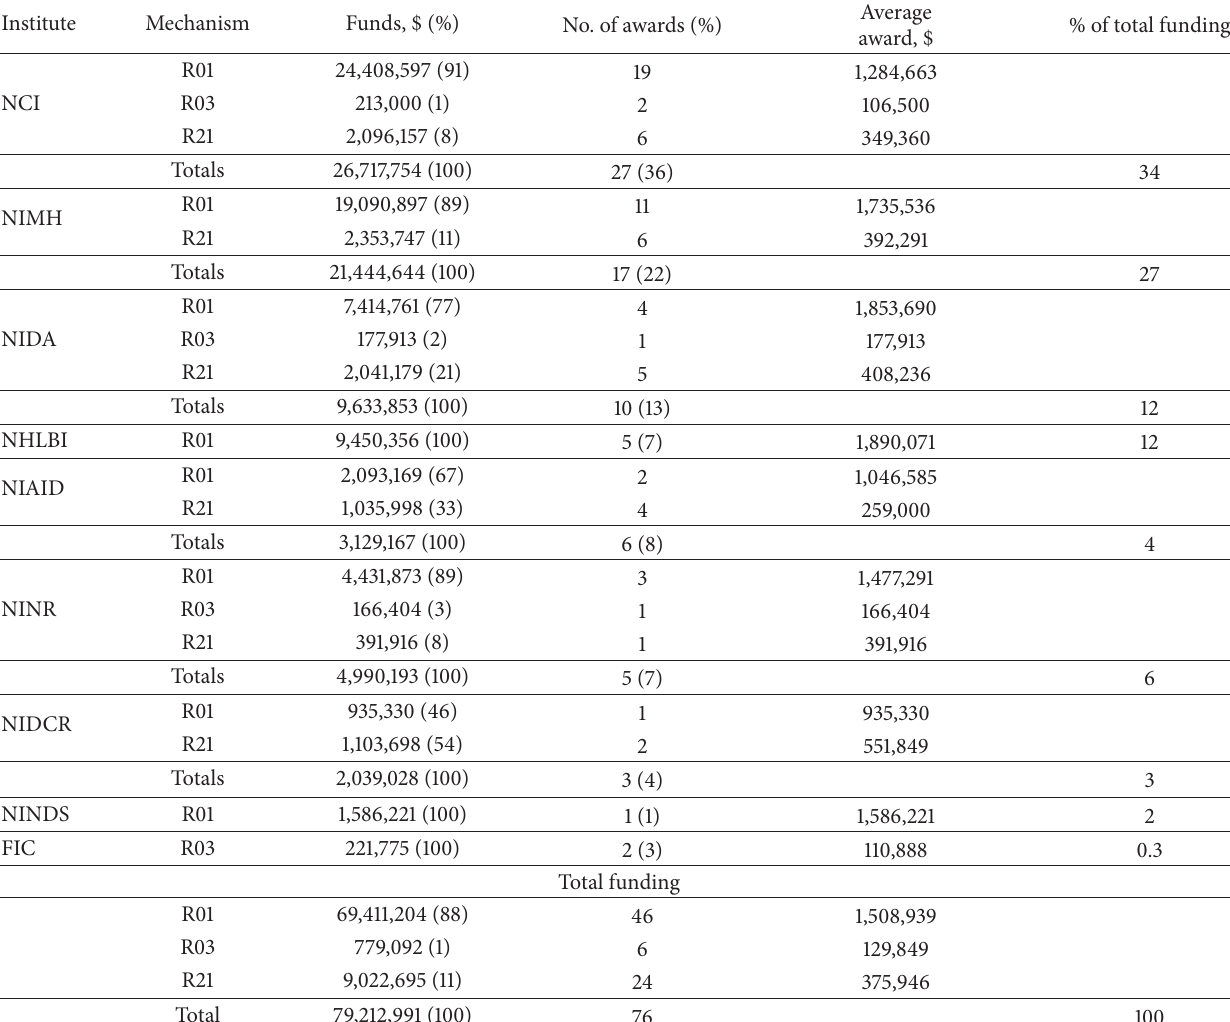
Table1:DisseminationandimplementationawardsbyNIHInstituteandgrantmechanism,2005–2012(out-yearfundingforprojectsrecently awarded is not